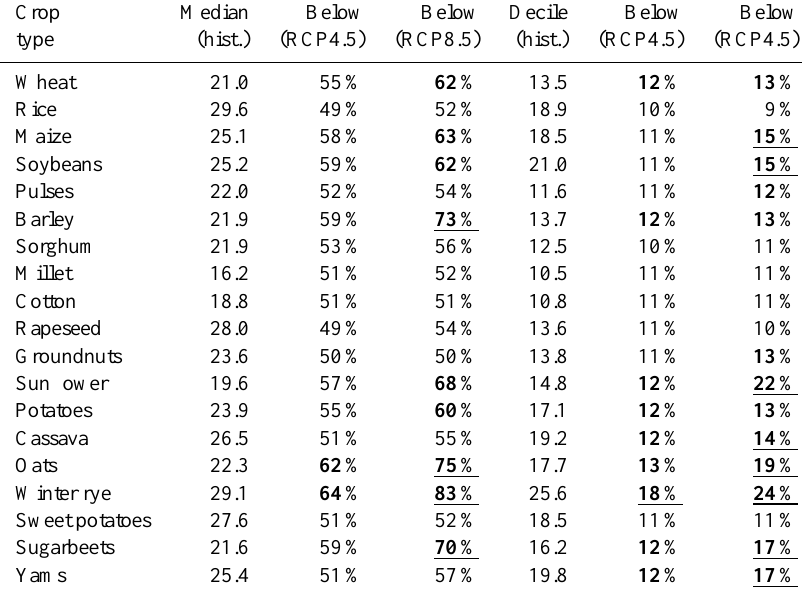
Table 3. Crop coverage-weighted multi-model estimates of median (50%) and lowest decile (10%) values of top 10cm soil moisture [kgm − 2 ] in historical case (hist.) and the projected percentage of area that will fall below those values in two future climate scenarios. Cases where the area increases by at least 20% (i.e., by 10% for median, 2% for lowest decile) are shown in bold, and cases where the area increases by at least 40% (20% for median, 4% for lowest decile) are bold and underlined. Crop Median Below Below Decile Below Below type (hist.) (RCP4.5) (RCP8.5) (hist.) (RCP4.5) (RCP4.5)